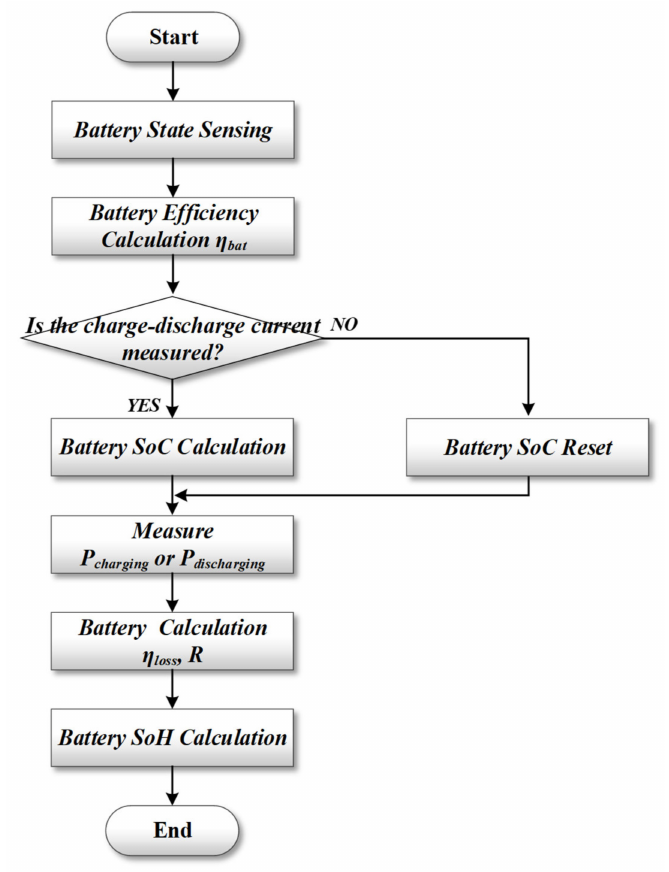
Figure 5. BMS algorithm that considers the battery